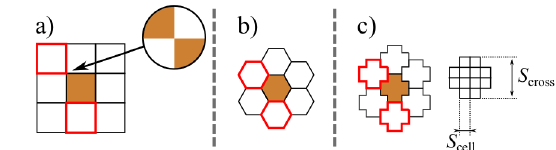
Figure 1. Possible connections between copper elements of different shape: ( a ) rectangles, ( b ) hexagons, ( c ) crosses. The red elements show vertical and diagonal neighbours. In ( a ) it is shown that vertically spaced elements result in an adequate connection, whereas diagonal elements result in singularities, due to a (theoretically) infinitesimally small connection. In ( b ) and ( c ) no singularities can occur, regardless of how neighbouring elements are connected to each other. In ( c ) the cross size ( S cross ) is defined and its seperation into different Sonnet Software cells with size S cell is